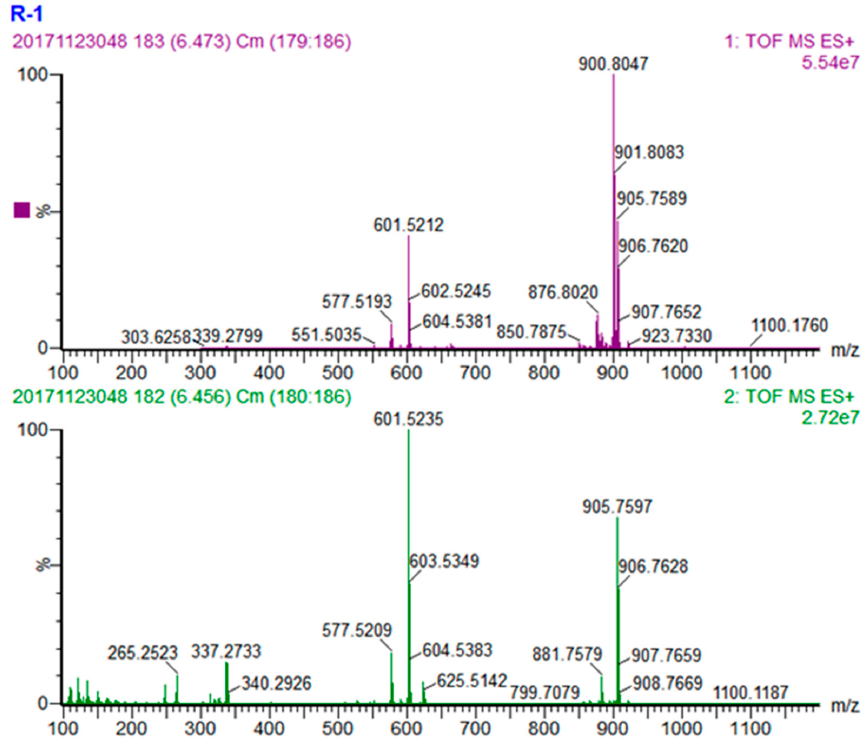
Figure 3. MS spectra of LOO. ( Upper ) MS1 spectrum and ( lower ) MS2 spectrum. The peak with a retention time of 6.30 min is an example for identification of TAG with three different fatty acids. The quasi-molecular ion of this TAG is [M + NH 4 ] + at m/z 874.7861 (Figure 4), and the molecular formula could be calculated as C 55 H 100 O 6 based on the MS1 information. MS fragments in the MS2 showed three fragment ion peaks [M- RCOO + H] + at m/z 601.5202, 577.5190 and 575.5037, respectively. Therefore, the elimi- nated fatty acid fragments could be calculated as m/z 273.2659, 297.2671 and 299.2824, which could be identified as palmitic, linoleic and oleic acids, respectively. The three di- acyl fragments was identified as OL + , PO + and PL + , and their natural abundances were 100%, 69% and 46%, respectively. The MS fragment PL + had the lowest natural abundance, suggesting that oleic acid has the highest bond energy and is the most difficult to be elim- inated; this TAG was tentatively identified as POL or LOP.